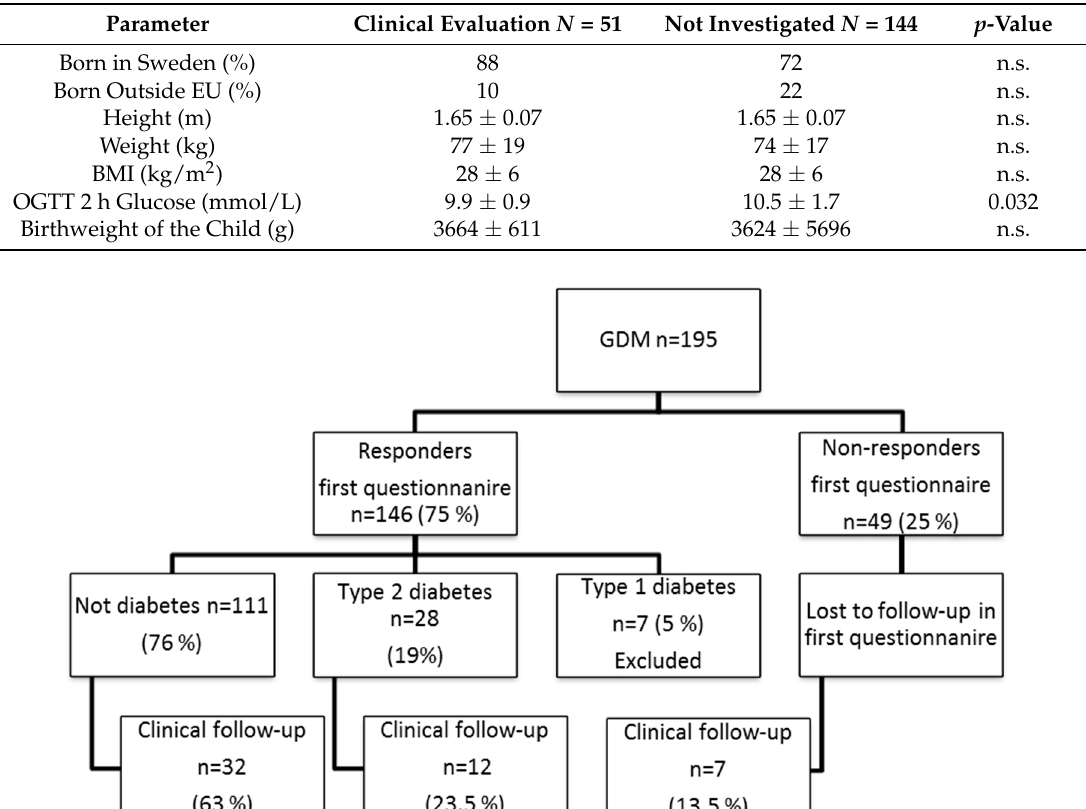
Table 4. Comparison of baseline data from 195 women diagnosed with gestational diabetes mellitus in the southeast region of Sweden during 1995–1999. In the present study, we invited women from the original cohort of 195 individuals living within 100 km of Linköping University Hospital for clinical examination; 51 accepted the invitation to participate in the study.